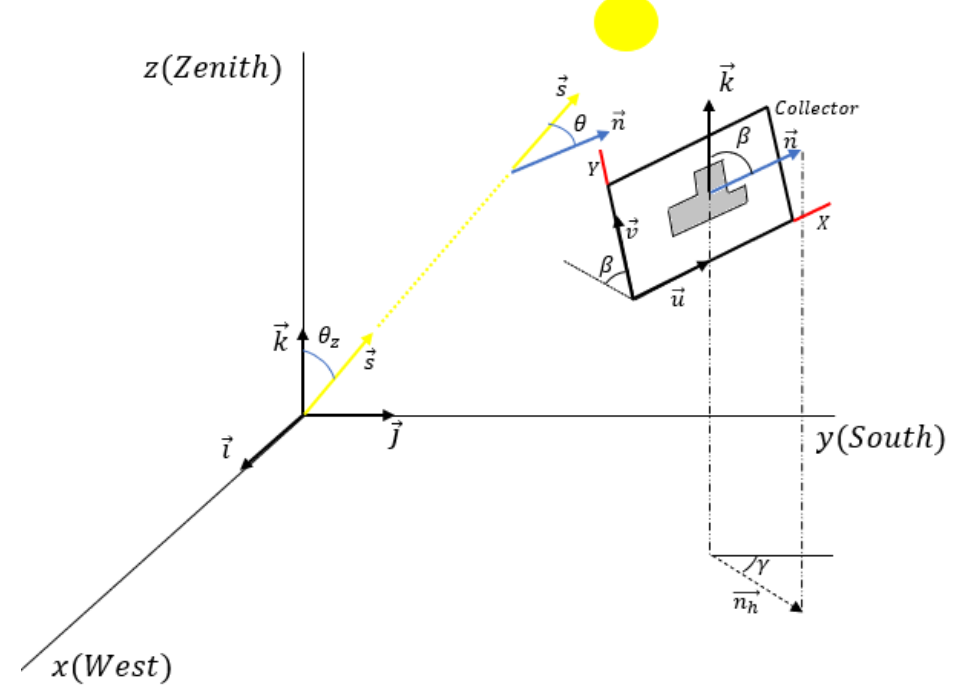
Figure 1. Astronomical and geometric magnitudes considered.